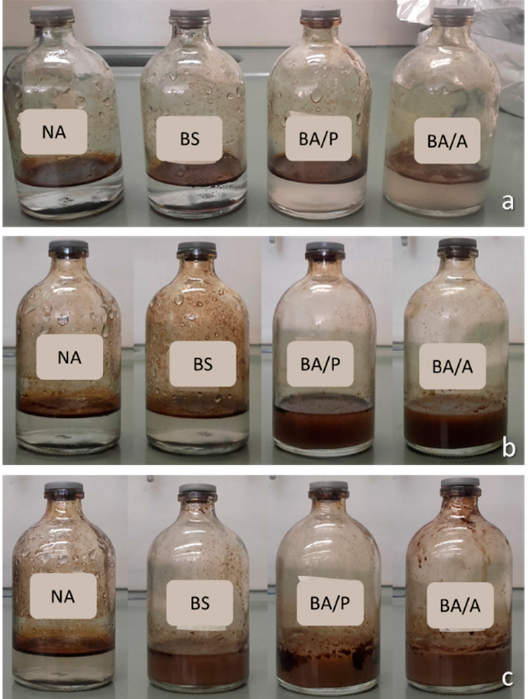
Figure 3. Visual aspect of the microcosm flasks at the beginning ( a ), after 7 days of the experiment ( b ) and at the end of the experiment (after 15 days) ( c ), for the different treatments: natural attenuation (NA), biostimulation (BS), bioaugmentation with inoculum pre-grown in petroleum (BA/P) and bioaugmentation with inoculum pre-grown in acetate (BA/A).